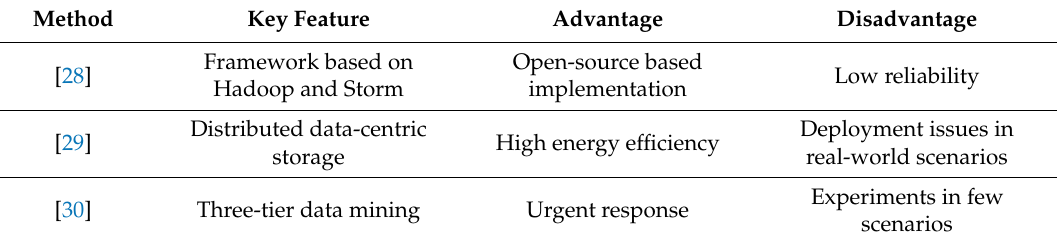
Table 2. Comparison of advantages and disadvantages of data